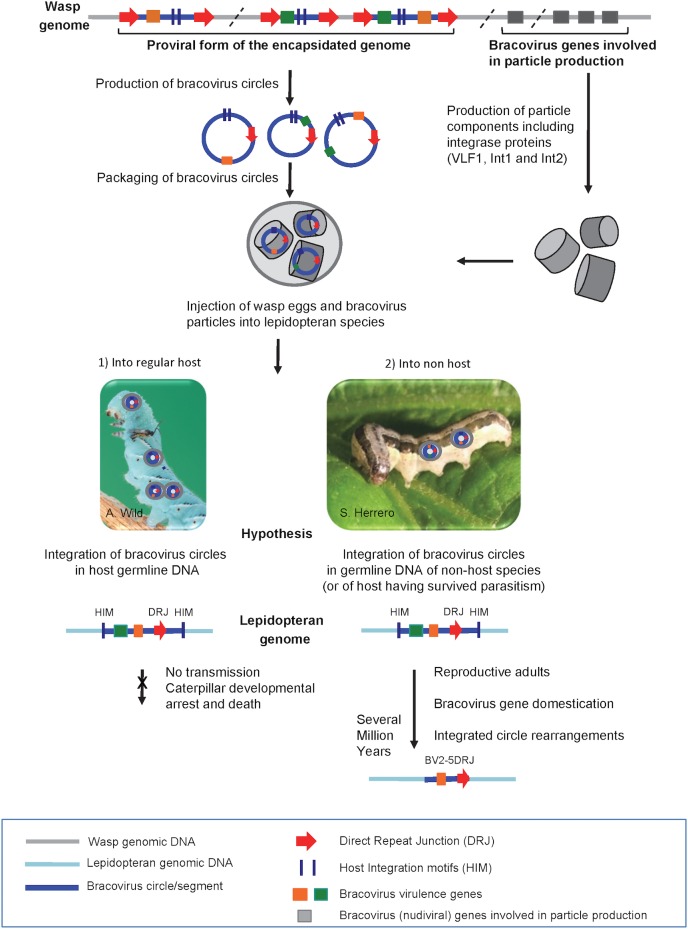
Production of bracovirus particles by the parasitoid wasp C. congregata and hypothesis on the process leading to transfer of bracovirus sequences to lepidopteran genomes.The BV genome is integrated in the wasp genome (in grey). It is composed of proviral segments (in blue) used to produce dsDNA circles (blue circles) packaged in nucleocapsids (grey cylinders) that encode virulence genes introduced into the host (coloured rectangles) and of BV genes that are involved in particle production (grey rectangles). The latter originate from a nudivirus and encode structural proteins, they are expressed in wasp ovaries where production of bracovirus circles also occurs. Direct Repeat Junctions (DRJ, red triangles) are involved in site-specific recombination allowing circularisation of linear molecules from proviral segments. The circles thus produced are packaged in BV particles that also contain several integrase proteins. The particles are injected in the lepidopteran host during wasp oviposition. Once in the host BV particles infect many lepidopteran cell types but do not replicate. BV circles can integrate into lepidopteran host genomic DNA (in light blue) by a mechanism involving most likely an integrase and mediated by Host Integration Motifs (HIM) indicated by dark blue lines. When injected into a regular host (1) BV virulence gene (coloured squares) expression leads to modifications in lepidopteran host physiology, such as inhibition of wasp egg encapsulation and alteration of developmental programming allowing wasp larvae to complete their development safely in the host body. Hypothesis: when integration of viral circles occurs in the germline the integrated forms are not transmitted because the host dies. When bracoviruses are injected into a caterpillar, which is not a regular host species (2) or is a resistant host (interrupting oviposition, destroying wasp eggs, etc.) the integrated viral form in germline DNA can be transmitted vertically. As bracovirus genes are adapted for expression in lepidopteran cells they can be readily domesticated. Once integrated in lepidopteran genomes the bracovirus sequences undergo rearrangements. Ultimately, after several million years, only the domesticated genes remain from the original integrated circle. We propose that stinging of non-host species could be the main route for bracovirus sequence transfer to Lepidoptera. This is based on the fact that the genome of M. sexta which is the regular host of Cotesia congregata does not contain genes acquired from CcBV, conversely genes found in Spodoptera exigua, which is not a host of Cotesia congregata, are more closely related to CcBV. This figure is mostly based on the life cycle of CcBV associated with C. congregata parasitoid wasp of M. sexta, HIM motifs have been identified in the bracovirus of M. demolitor, the picture of S. exigua is shown as an example of C. congregata non-host species.